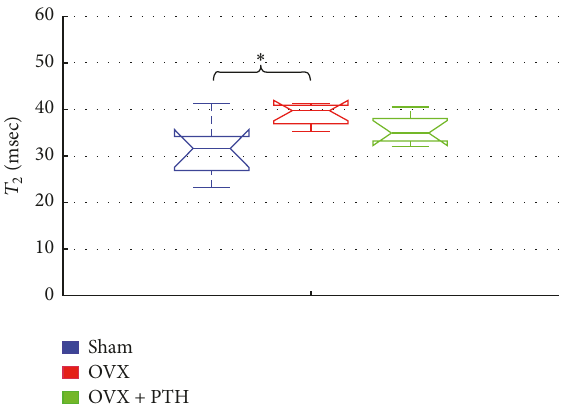
Figure 9: Therapeutic treatment experiment: 𝑇 2 measurements of Sham, OVX, and OVX + PTH femurs bones, measured 11 weeks after operation. Significant increase in 𝑇 2 for the femurs OVX bones compared to the OVX + PTH and the Sham femurs bones when measured in the peripheral zone (by Kruskal-Wallis test followed by Bonferroni multiple-comparison test ∗ 𝑃 < 0.04 , ∗∗ 𝑃 < 0.02 ).